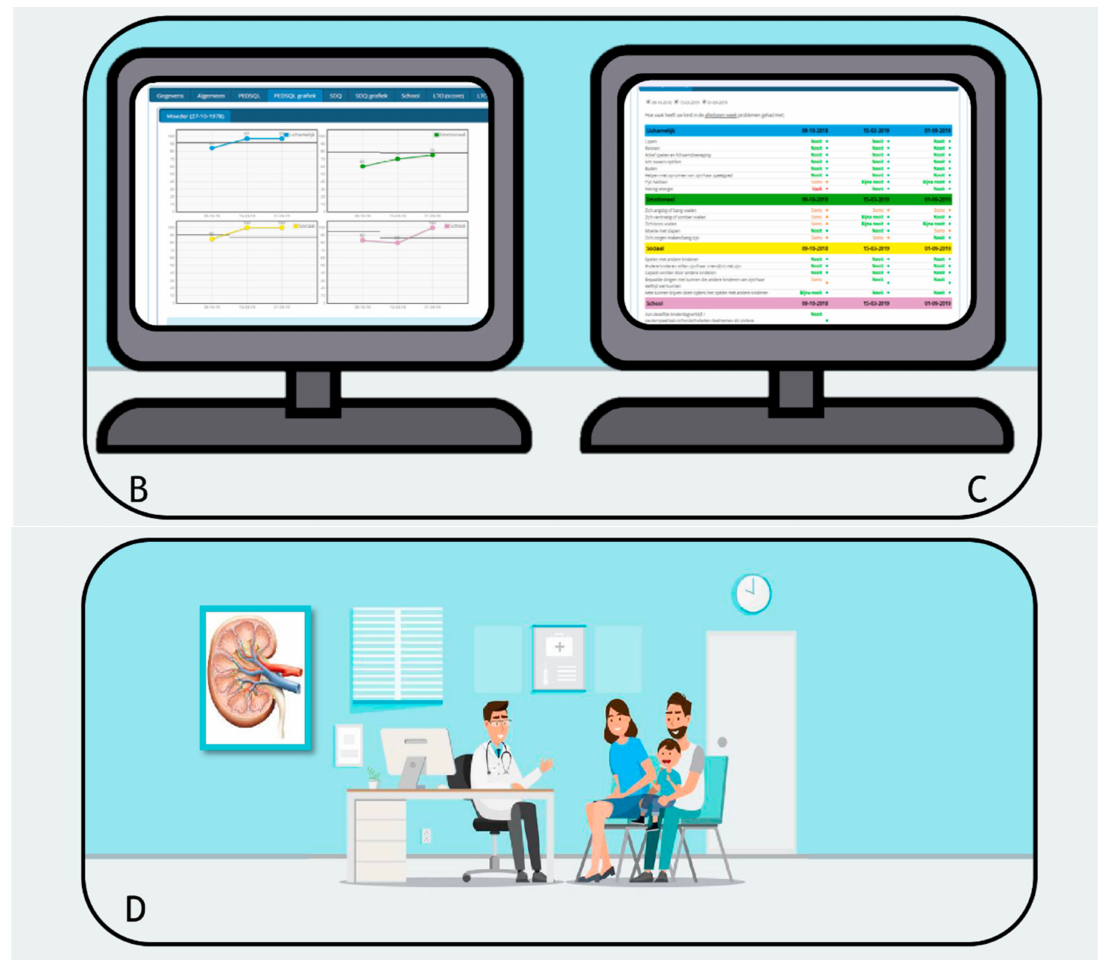
Figure 1. The KLIK method in daily clinical practice. ( A ) The patient and/or parents receive a reminder by email to complete the PROMs 7 days before a scheduled outpatient consultation. After completion, the answers of the PROMs are transformed into a KLIK ePROfile; ( B ) Literal representation of the answers using traffic light colors in order to easily identify items that need special attention (yellow or red); ( C ) HRQoL and change over time is visually displayed using graphs. The red line indicates reference data; ( D ) The clinician discusses the ePROfile with the patient and/or